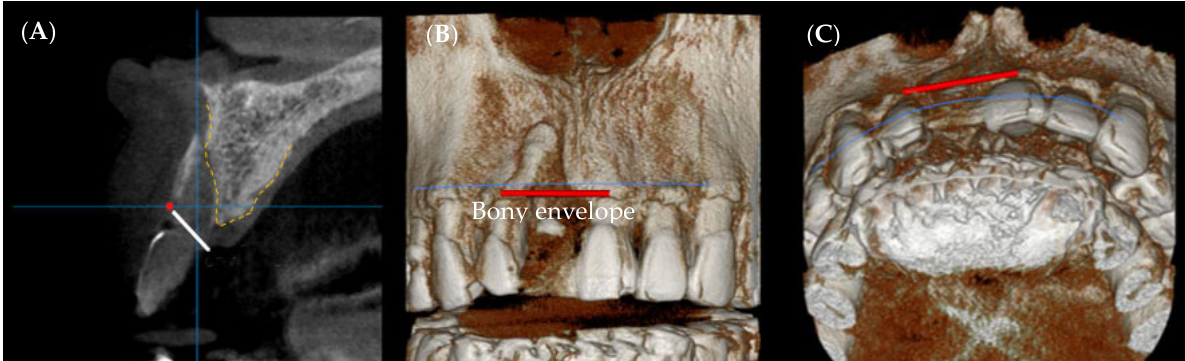
Figure 3. (A) CBCT sectional view. Note that the bony envelope appears as a red spot, ( B , C ) 3D radiographic analysis of bony envelope level.